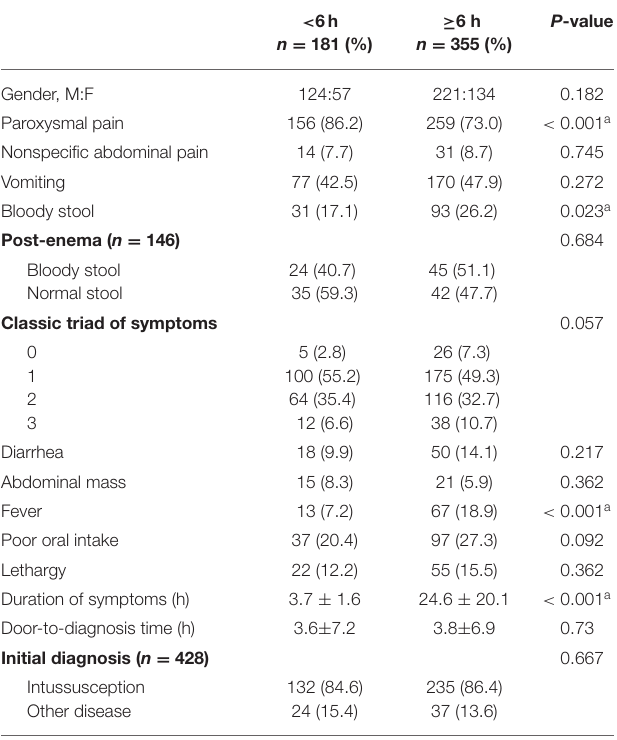
TABLE 2 | Clinical findings of enrolled patients in the early ( < 6h) and late groups ( ≥ 6h) classified based on the duration of symptoms.